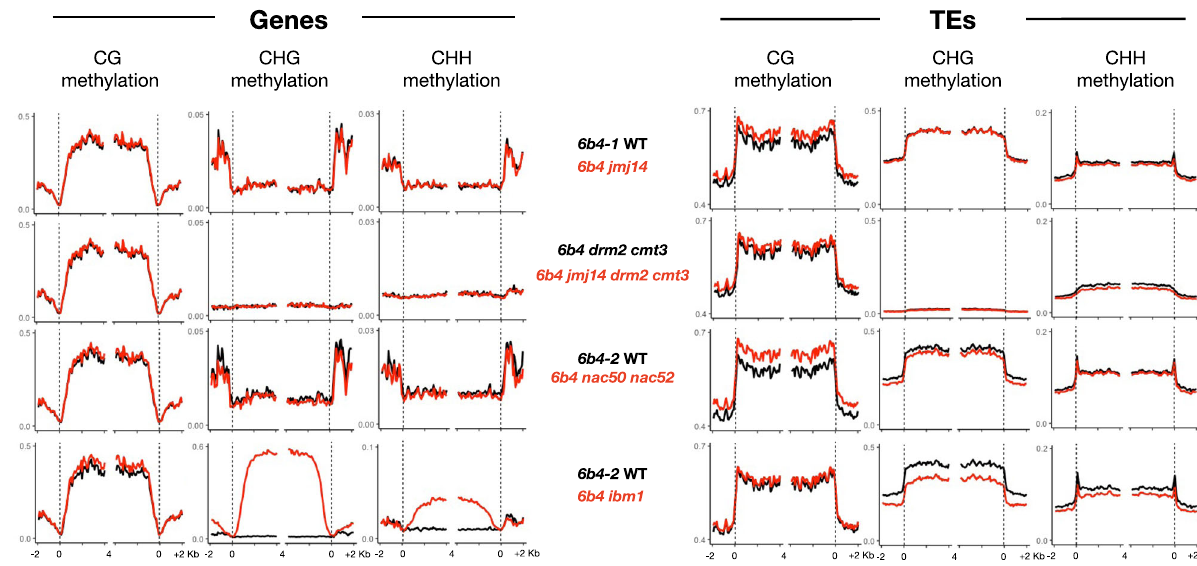
Fig. 6 JMJ14 and NAC50/NAC52 do not affect CHG and CHH methylation of endogenous genes and TEs. The gene body of endogenous genes (left panels) and TEs (right panels) were annotated according to the TAIR10 reference genome and aligned at the 5 ′ and 3 ′ ends (dashed lines), and average CG, CHG and CHH methylation levels for 100-bp intervals were plotted in pairwise comparisons between 6b4-1 WT and 6b4 jmj14 , and 6b4 drm2 cmt3 and 6b4 jmj14 drm2 cmt3 of 5-week-old plants, and 6b4-2 WT and 6b4 nac50 nac52 , and 6b4-2 WT and 6b4 ibm1 for 8-week-old plants. This analysis showed that CHG and CHH methylation in the body of endogenous genes and TEs is not affected in 6b4 jmj14 and 6b4 nac50 nac52 plants, whereas CHG and CHH is substantially increased in the body of endogenous genes in 6b4 ibm1 plants. Bisul fi te data were analyzed using R version